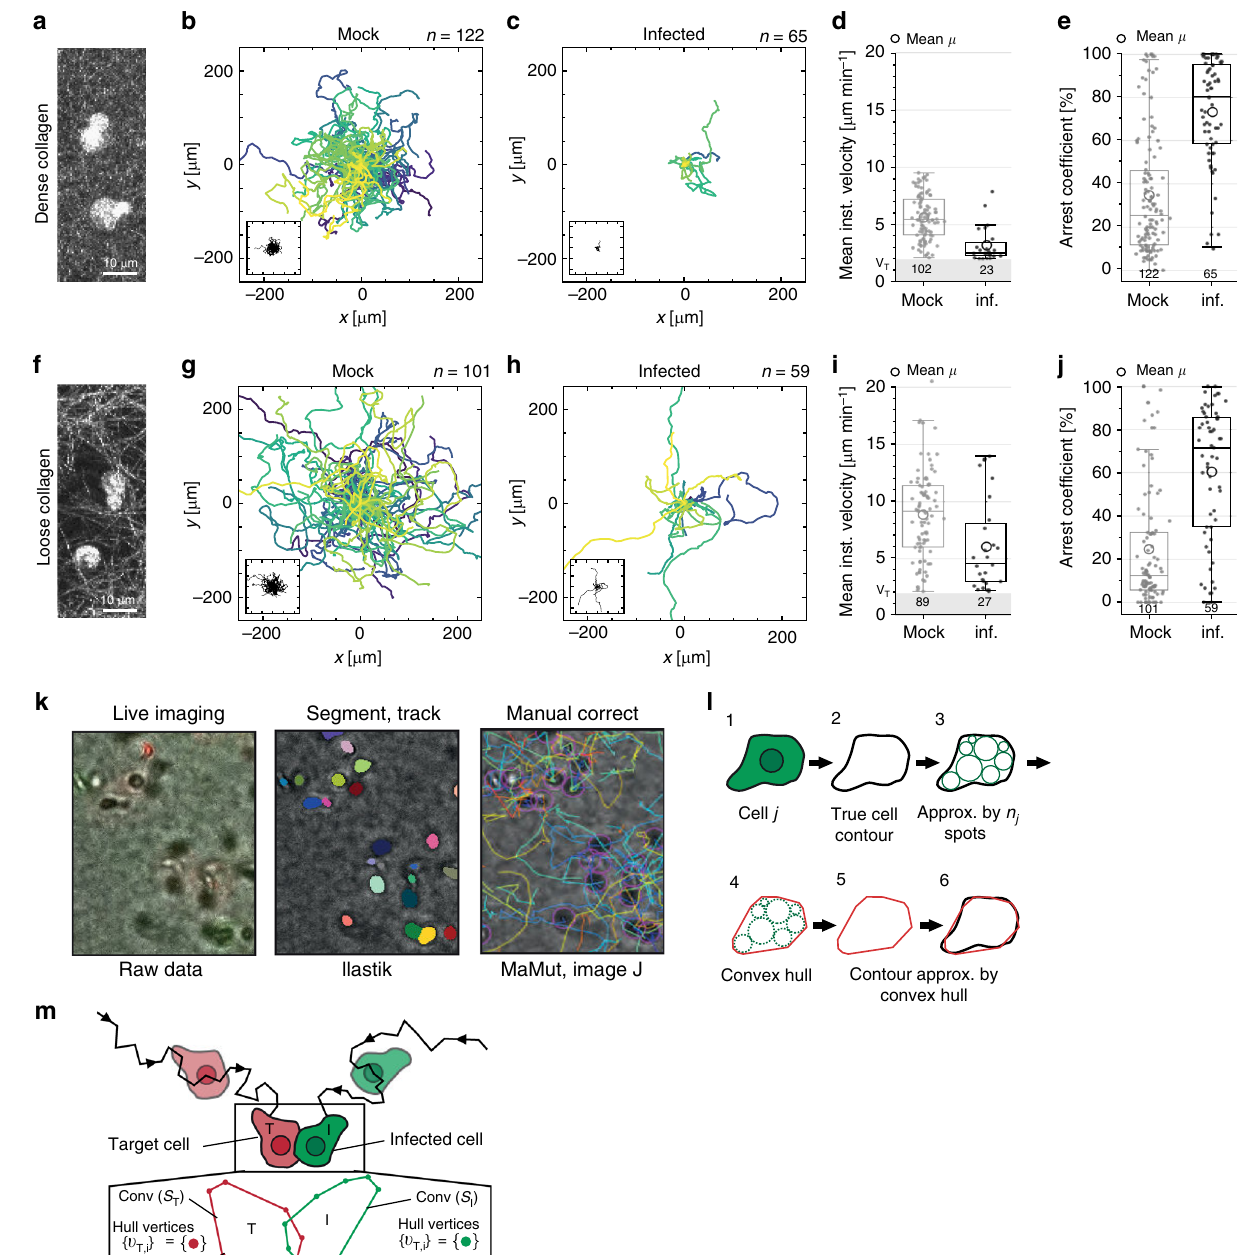
Fig. 4 Step 5: Motility analysis in different collagen densities. Cell migration analysis. Mock CD4 T cells and puri fi ed HIV-1 infected cells were stained with red and green PKH cell dyes, respectively, mixed and embedded in loose or dense collagen. Cells were imaged every 30 s, segmented and tracked for 60 min. a , f Maximum projection of 10 µ m stacks of confocal re fl ection microscopy showing lymphocytes in a compact collagen meshwork of dense collagen ( a ) and in a fi brillary structure in loose collagen ( f ). Scale bar 10 µ m. b , c , g , h Trackplots of mock infected and infected CD4 cells in dense and loose collagen. The inset shows a zoom-out to visualize the maximal extent of the longest tracks. The analyzed cell number is indicated by n . d , i Mean instantaneous velocity of motile cells (faster than 2 µ m min − 1 as minimum velocity marked by gray bar). e , j Arrest coef fi cient of all cells indicating the fraction of track lengths displaying arrest (<2 µ m min − 1 ). Absolute numbers of cells analyzed are indicated below the boxes. Box and whiskers in Tukey style with mean values indicated by circles are shown. k Work fl ow for advanced segmentation and tracking. From left to right: Wide- fi eld image from live microscopy, overlay with segmentation result as computed using Ilastik, manual track correction with Image J plugin MaMut. See Methods for details. l In case one cell was detected by multiple spots, these were joined to compute a convex hull used for contact analysis. See Methods for details. m De fi nition of contact based on overlapping cell shapes as approximated by convex